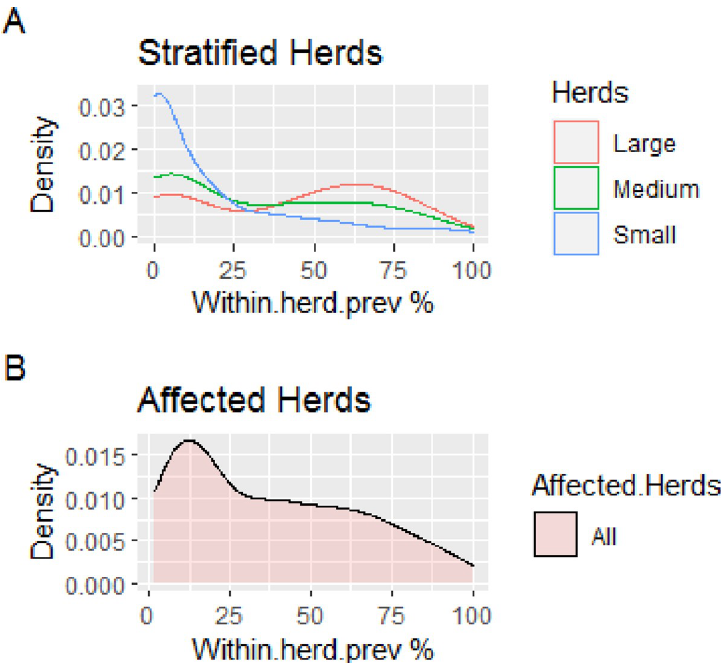
Fig 2. (A) Within-herd bTB prevalence distribution for stratified herds (Visualizing multiple distributions simultaneously) (B) Within-herd bTB prevalence distribution for affected herds (bTB prevalence > 0).